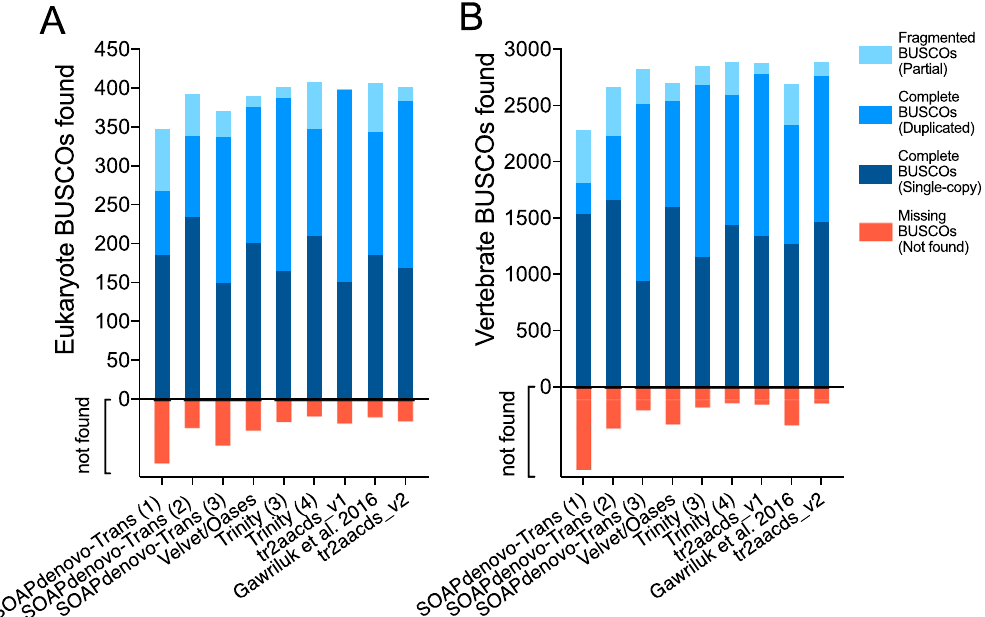
Figure 3. BUSCOs identified in each clustered/multi-kmer transcriptome assembly. SOAPdenovo-Trans (1): no filtering; (2): light filtering of poor quality read pairs, combined with in silico normalization; (3): moderate filtering of poor quality read pairs; Velvet/Oases: moderate filtering of poor quality read pairs; Trinity (1): light filtering of poor quality read pairs, combined with in silico normalization; (2): light filtering of poor quality read pairs, combined with SEECER error correction; (3): moderate filtering of poor quality read pairs; (4) moderate filtering of poor quality reads and SEECER error correction; tr2aacds merged assemblies (1): pre-v2.3.2 Trinity; (2) including v2.3.2 Trinity.